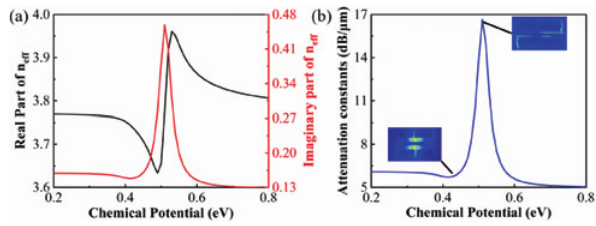
Figure 2: (a) Real and Imaginary part of n eff . (b) Attenuation constants at different μ c with the width of w = 100 nm and the thickness of t 1 = 20 nm.